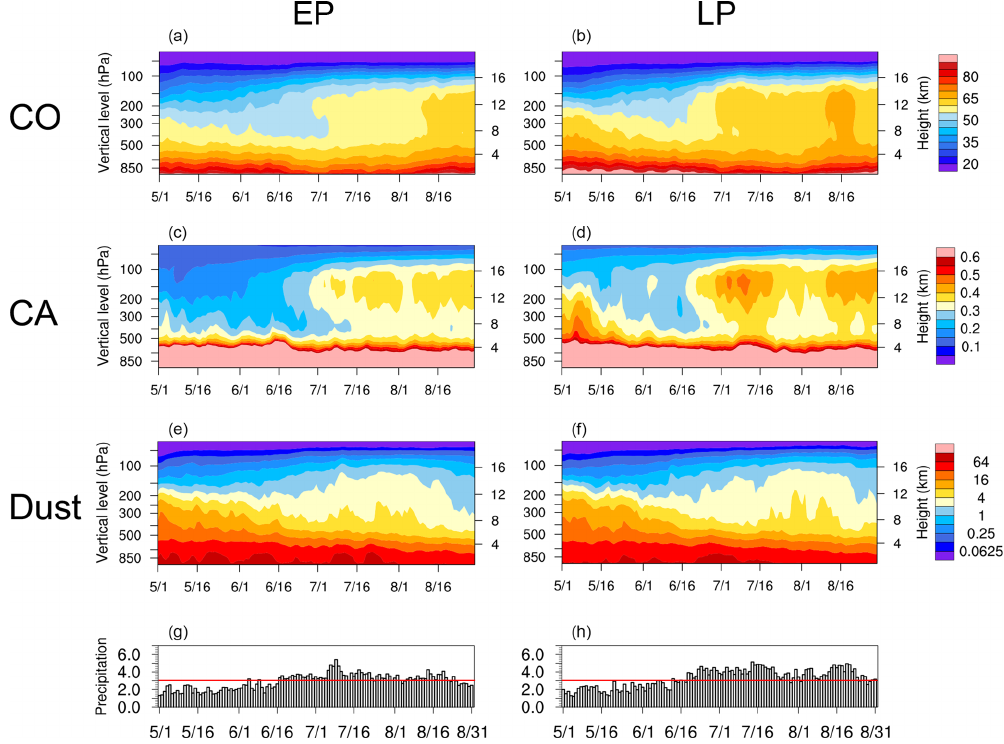
Figure 9. Time–height cross sections showing daily variations in (a) CO (ppbv), (c) CA (ppbm), (e) dust (ppbm) and (g) precipitation (mmday − 1 ) during early part years over the DSCC stem regions (25–35 ◦ N, 65–115 ◦ E). Panels (b) , (d) , (f) and (h) are the same as (a) , (c) , (e) and (g) but for late part years. Red lines in (g) and (h) show the reference value of precipitation intensity (3mmday − 1